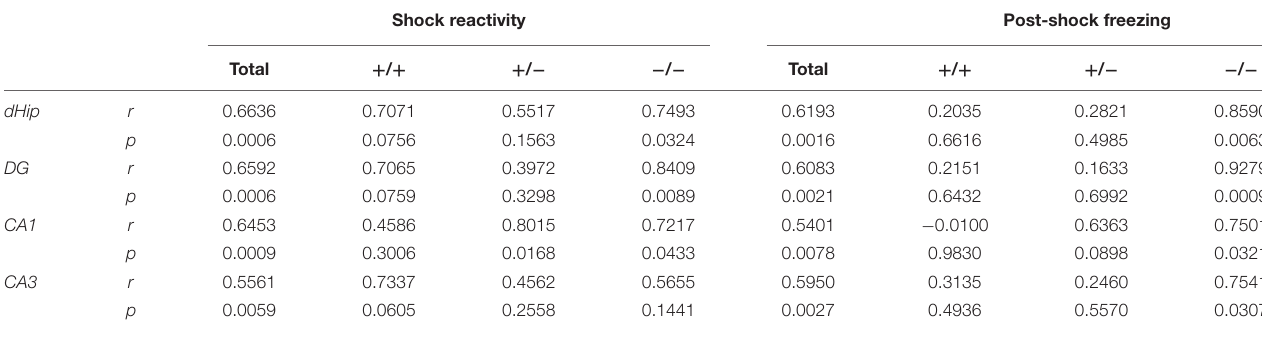
TABLE 1 | Pearson’s correlation of shock reactivity and post-shock freezing with c-Fos density in the dorsal hippocampus and its subregions of FS − and FS +